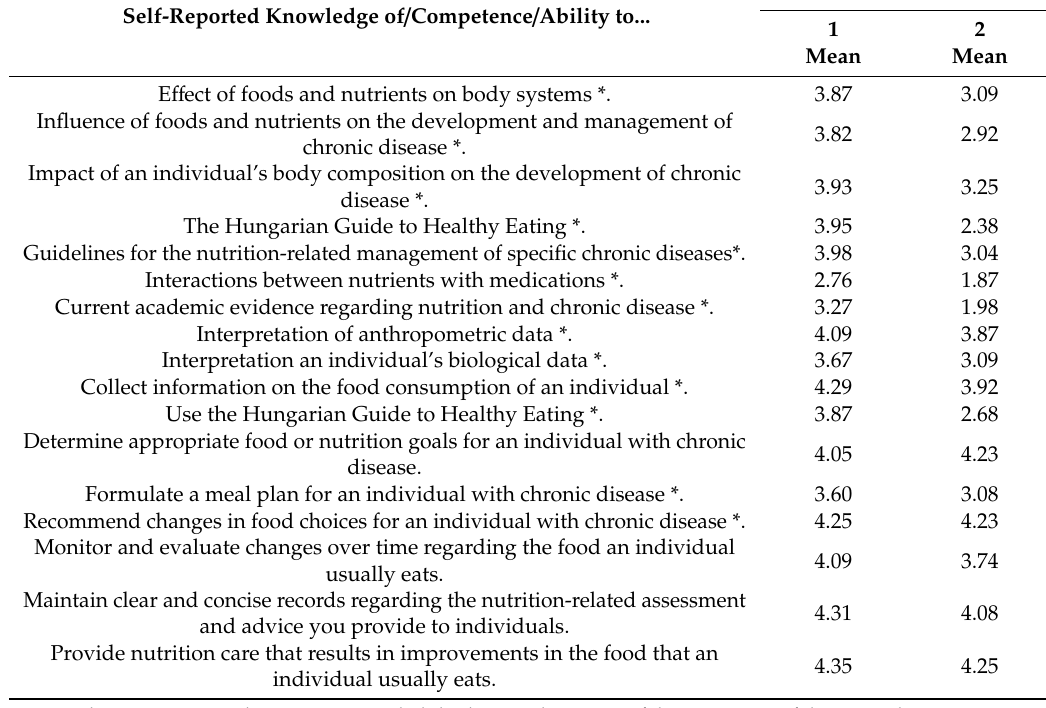
Table 5. Self-reported competence evaluation concerning nutrition-related issues, measured on a 1–5 Likert scale (1—absolutely not agree and 5—totally agree), significant di ff erences at p = 5% and levels are indicated by *.